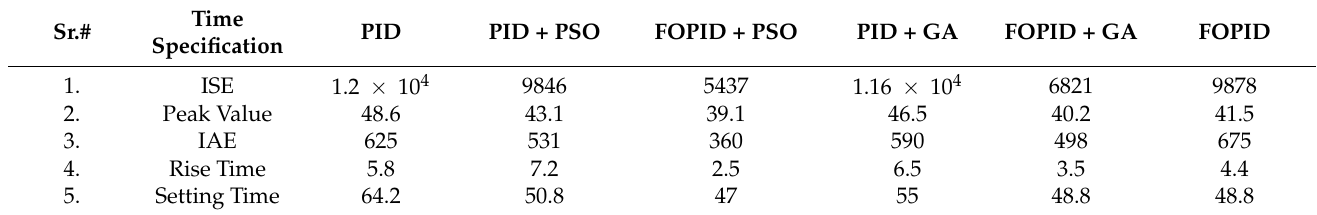
Table 5. Comparison of FOPID and PID performance in terms of different time